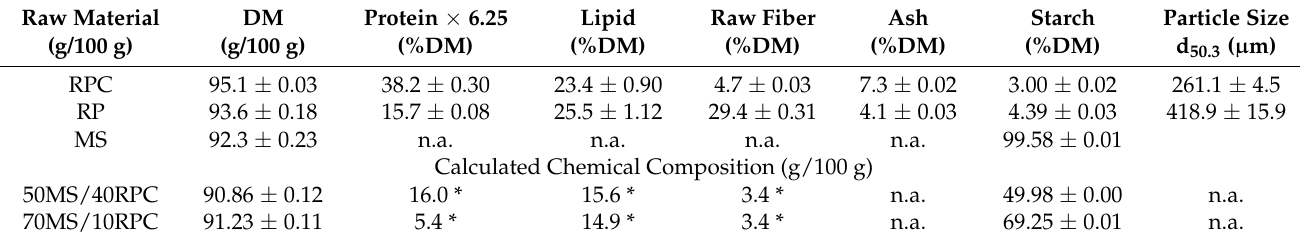
Table 1. Chemical composition and particle size of rapeseed press cake (RPC), rapeseed peel (RP), maize starch (MS) and the mixtures of starch with 10 and 40 g/100 g (w.b.) RPC. DM = dry